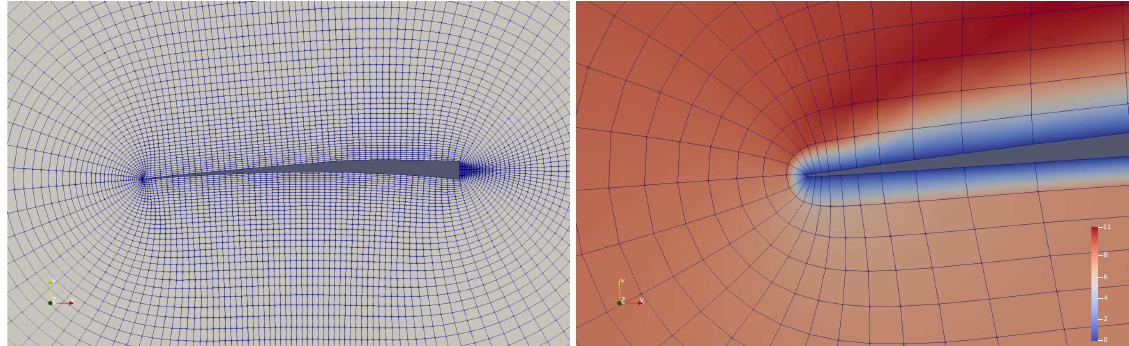
Figure 8. L 1 grid resolution and blunt leading edge with velocity contours (in m/s).